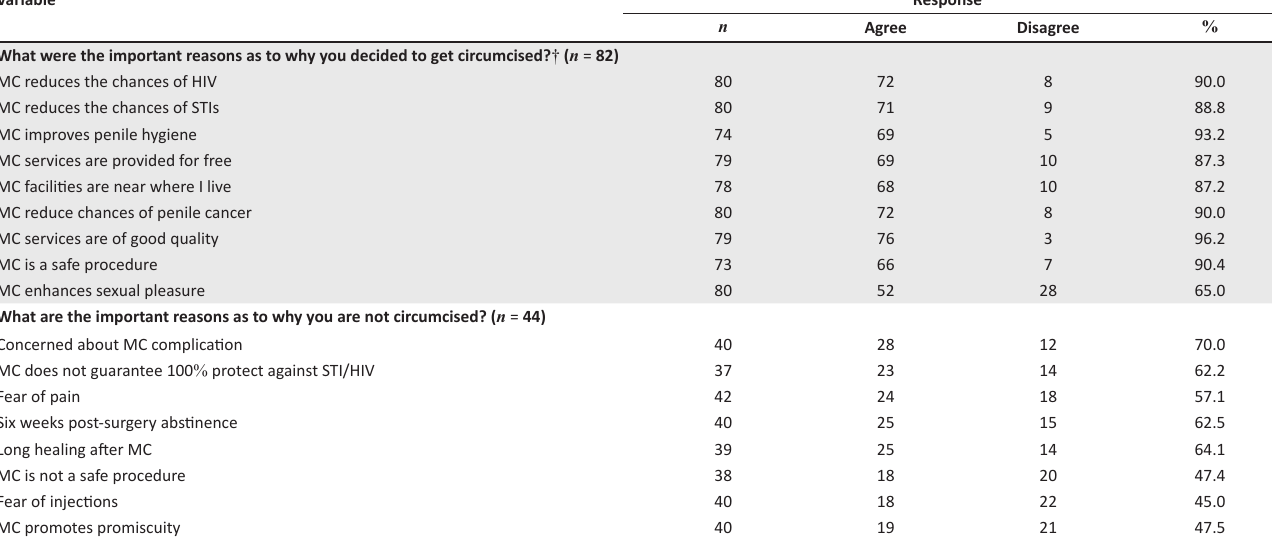
TABLE 2a: Exposure variables for male circumcision status among college youth, Ndola – 2016 ( N = 136). Variable